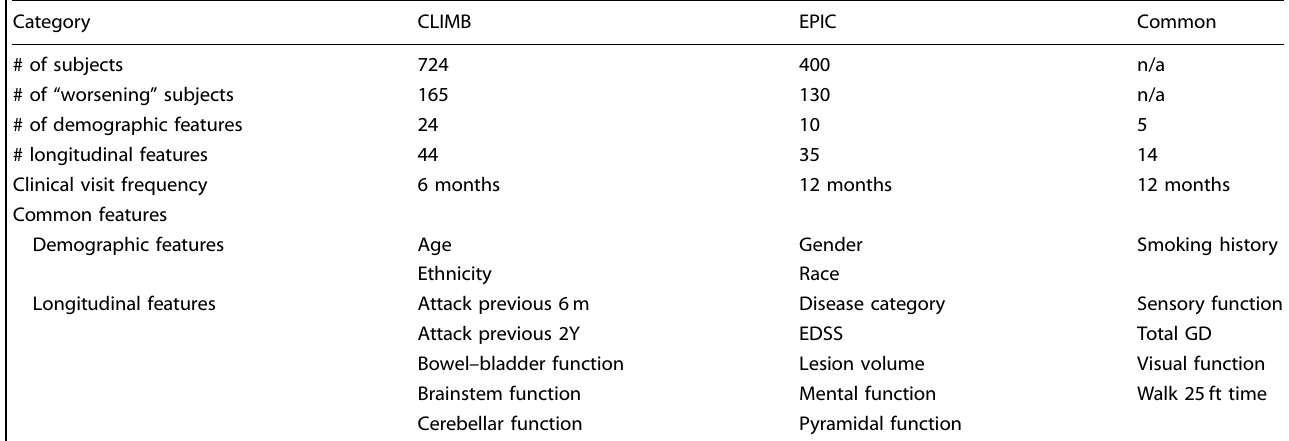
Table 6. Comparison of the CLIMB and EPIC